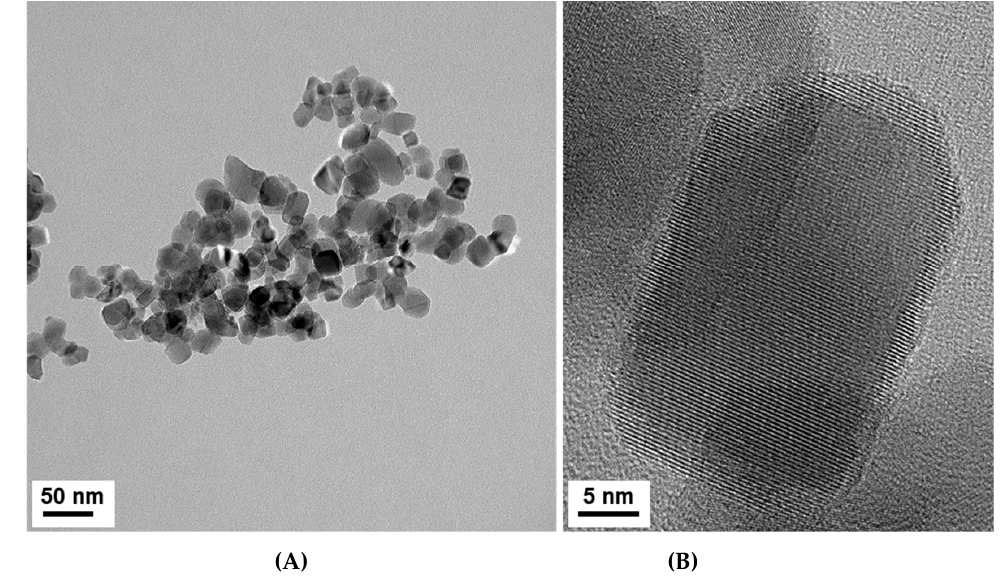
Figure 3. HRTEM images of TiO 2 NP ( A ) and a zoomed in detail ( B ).